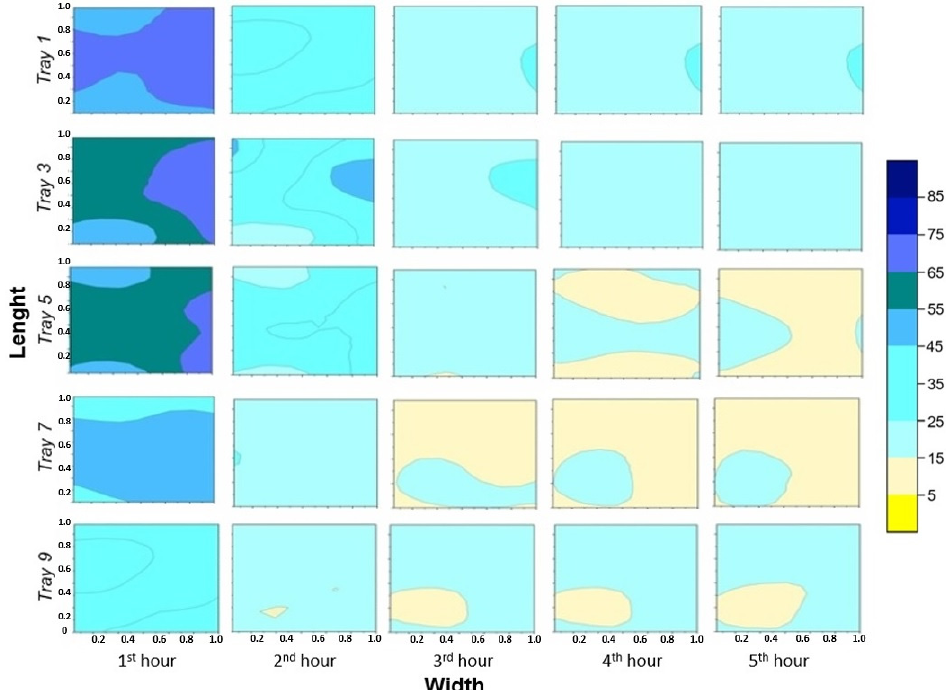
Figure 5. Drying dynamics inside the electric dryer chamber (1–5 h). Tray 9 is located near the bottom heat source. Scale refers to percentage of weight remaining.